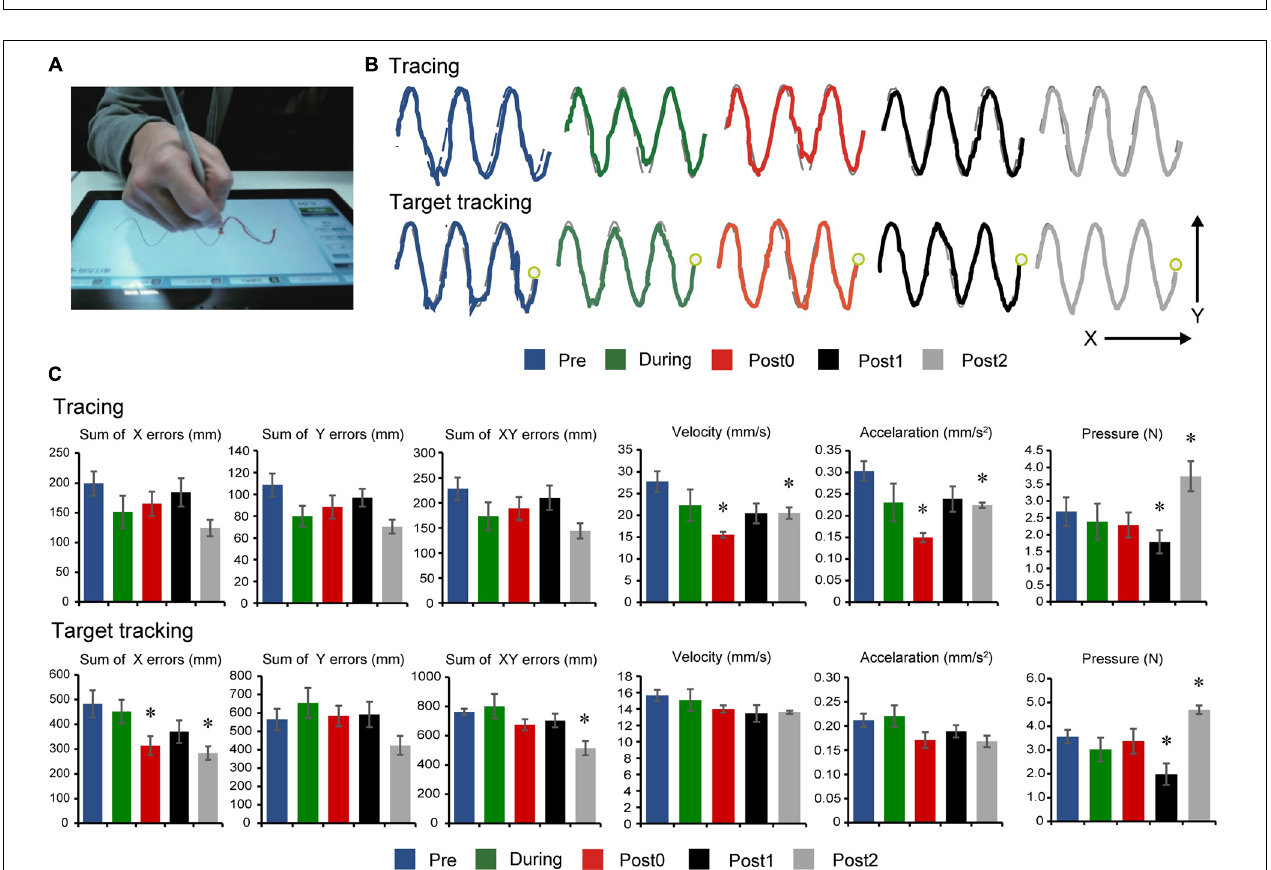
FIGURE 4 | Drawing test results. (A) Experimental setup showing the instrumented tablet with the participant. (B) Representations of the participant’s performances on the drawing tests at baseline (Pre), after 6- and 12-weeks of FEST (During and Post0), as we as during follow-up assessments 6- and 12-weeks after FEST (Post1 and Post2) are shown. Tracing performance is shown in the upper graphs, when the participant was required to follow the outline of a sine wave at a self-selected speed. Target tracking performance is shown in the lower traces, when the participant was required to follow a moving target on the screen-. (C) The sum of error ( x , y , and xy directions), velocity, acceleration, and pressure performance during the tracing task are shown in the upper graphs and the target tracking task in the lower graphs. TABLE 1 | Clinical measurements scores, including the functional independence measure (FIM) self-care, Fugl-Meyer assessment (FMA) of the upper-limb (U/L) function, and Motor Activity Log (MAL), amount of use score (AS) and how well score (HW). Pre During Post0 Post1 Post2 FIM self-care (max score: 42)